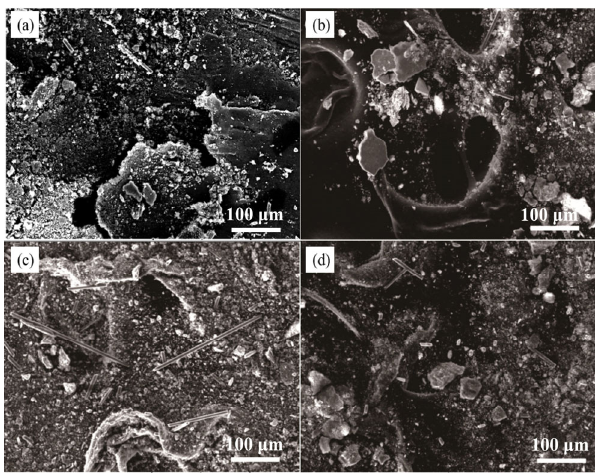
Fig. 11 Morphologies of worn debris during friction between 37%C f /LAS composites and the counter steel ball with sample temperature of (a) room temperature, (b) 200 °C, (c) 300 °C, and (d) 400